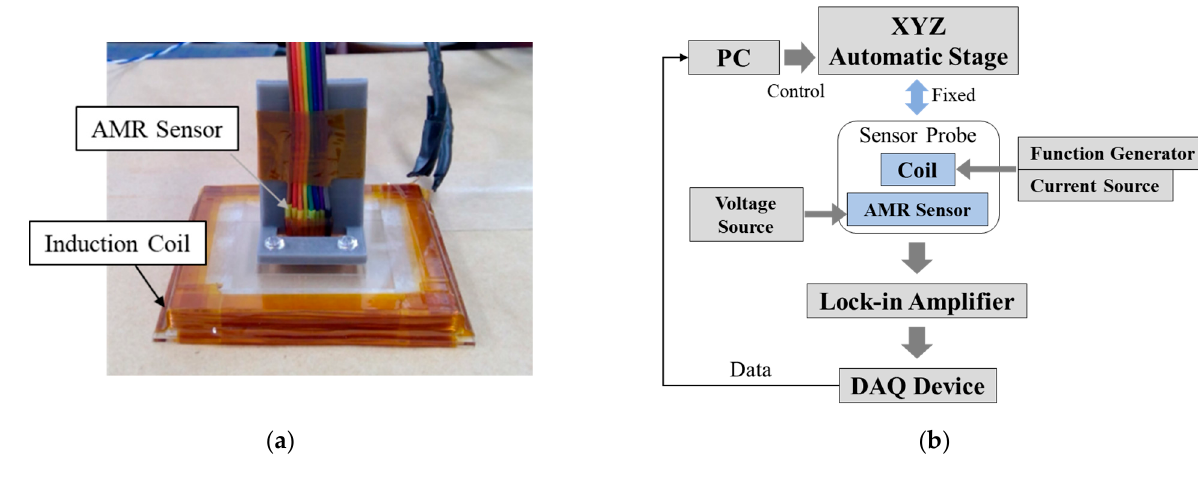
Figure 1. ( a ) Prototype sensor probe, ( b ) Measurement system.